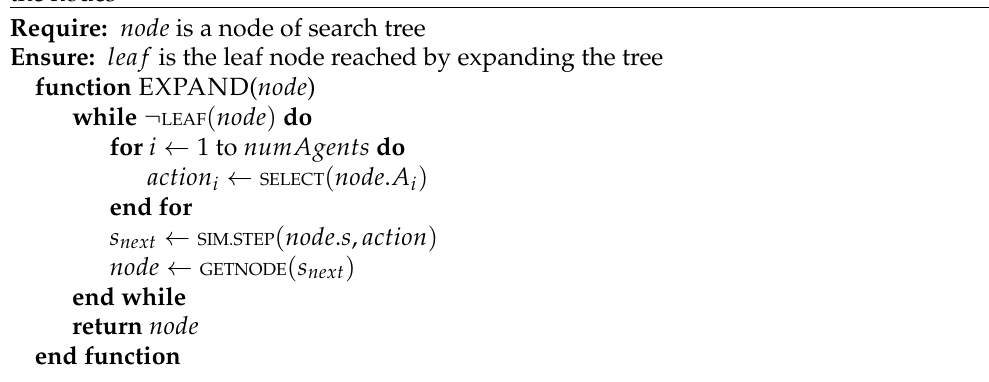
Algorithm 2 EXPAND algorithm that traverses the search tree using the statistics of the